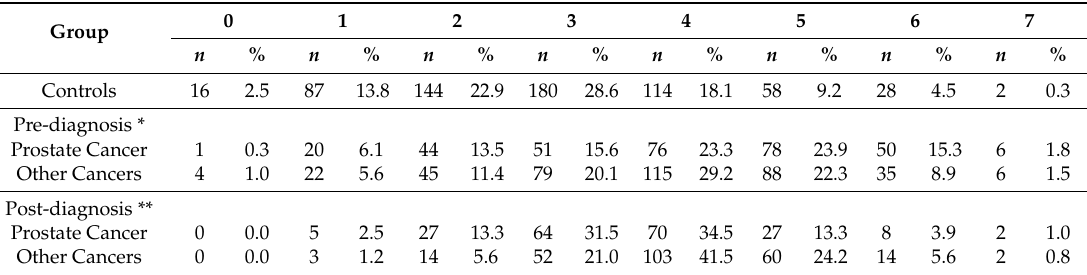
Table 5. Accumulated risk factors of study